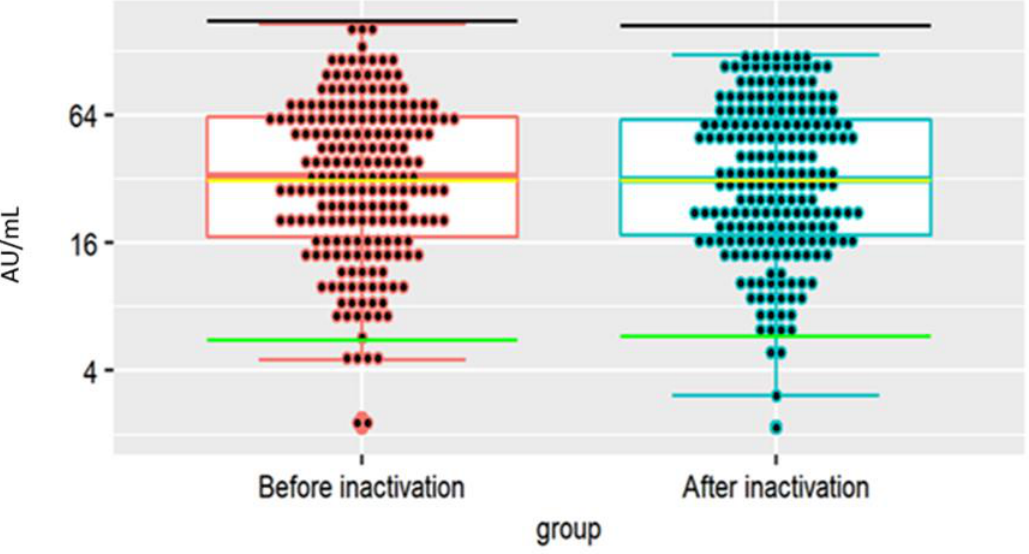
Figure 3. Comparison of iFlash test reactivity (anti-S1 SARS-CoV-2 IgG antibody assay) in 206 CP donations before and after inactivation—no statistically significant differences in the pairwise Wilcoxon test were observed, p = 0.502.